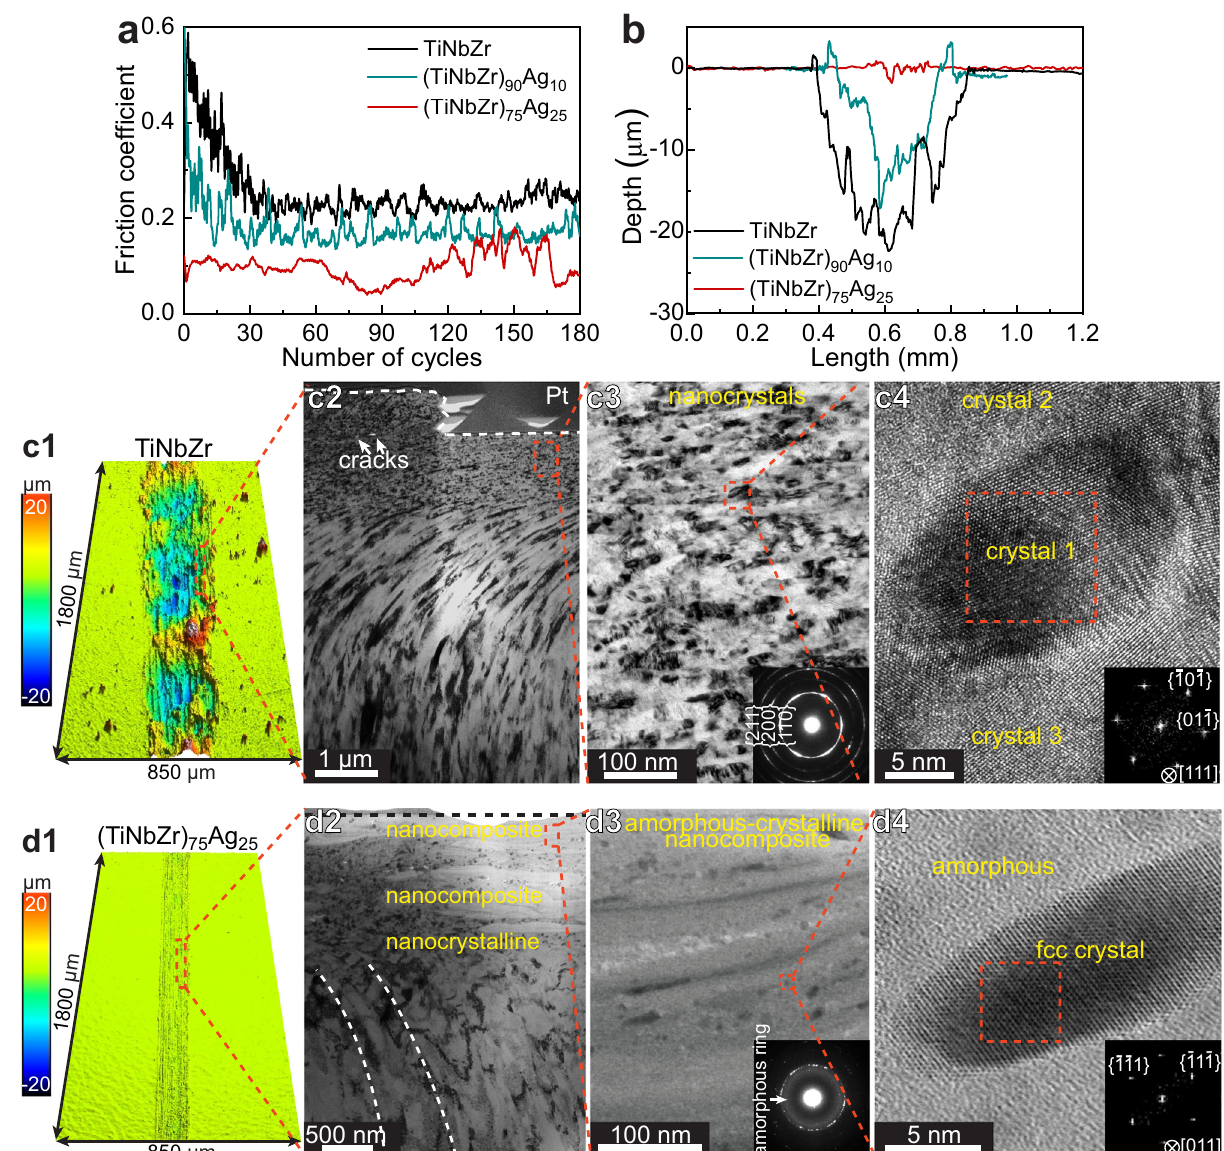
Fig. 2 Wear behavior of the TiNbZr, (TiNbZr) 90 Ag 10 , and (TiNbZr) 75 Ag 25 alloys. a Friction coef fi cients as a function of sliding cycles for the three alloys. b 2D cross-sectional pro fi les of the wear tracks. c1 3D pro fi le of the TiNbZr wear surface. c2 - c4 TEM images revealing the grain re fi nement in the worn TiNbZr alloy. The TEM lamella was prepared from the edge of the wear track, as the TiNbZr alloy fi lm was completely removed at the center of the wear track. d1 3D pro fi le of the (TiNbZr) 75 Ag 25 wear surface. d2 - d4 Structure of the worn (TiNbZr) 75 Ag 25 alloy. d2 TEM image presenting a ~400-nm-thick amorphous-crystalline nanocomposite on the surface. d3 Annular bright fi eld (ABF)-STEM image displaying the structure of the nanocomposite. d4 Atom- resolved ABF-STEM image of the nanocomposite, presenting a fcc structured nanocrystal embedded in the amorphous matrix. The inset image in ( c3 ) and ( d3 ) are the corresponding SAED patterns, and the insets in ( c4 ) and ( d4 ) are the FFT patterns of the regions marked by the red